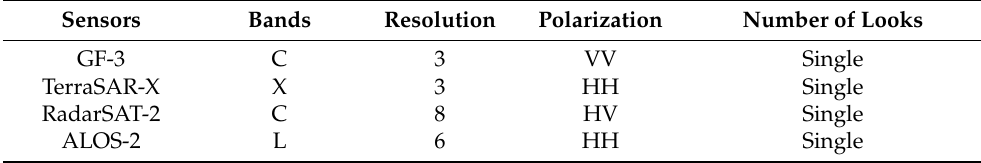
Table 1. Real SAR image parameters. Sensors Bands Resolution Polarization Number of Looks GF-3 C 3 VV Single TerraSAR-X X 3 HH Single RadarSAT-2 C 8 HV Single ALOS-2 L HH